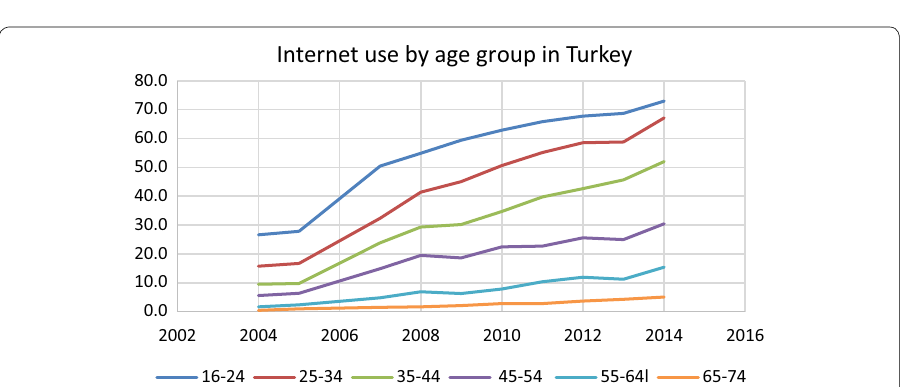
Fig. 2 Internet use by age group in Turkey, 2004–2014 (Source: TurkStat 2014)